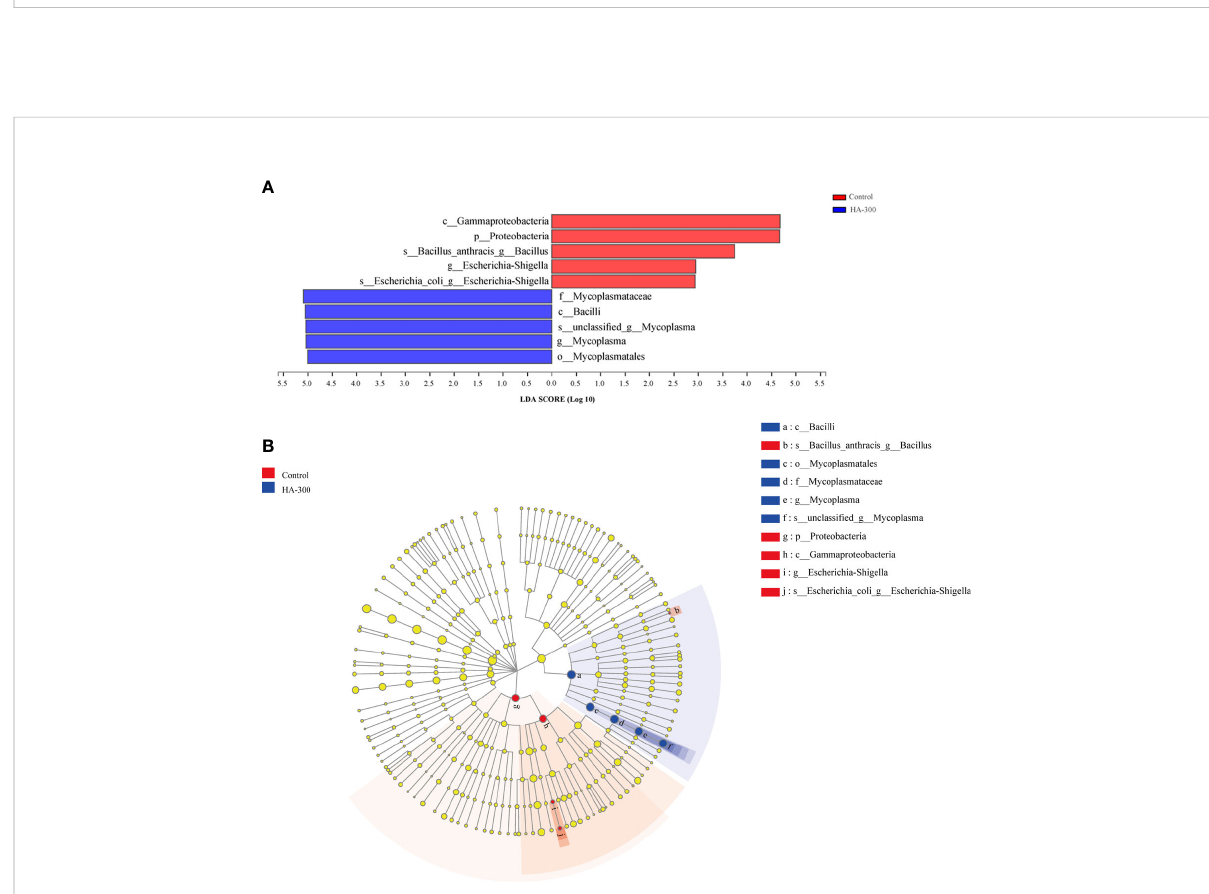
FIGURE 6 Linear discriminant analysis effect size (LEfSe) analysis of intestinal micro fl ora of largemouth bass. (A) Histogram of linear discriminant analysis (LDA) value, with the length representing the LDA score (LDA >2). (B) Evolutionary branch diagram, with yellow nodes indicating no signi fi cant difference in intestinal micro fl ora, and the red and blue nodes representing the differential microbiota classes that play a signi fi cant role in the control and HA-300 groups,